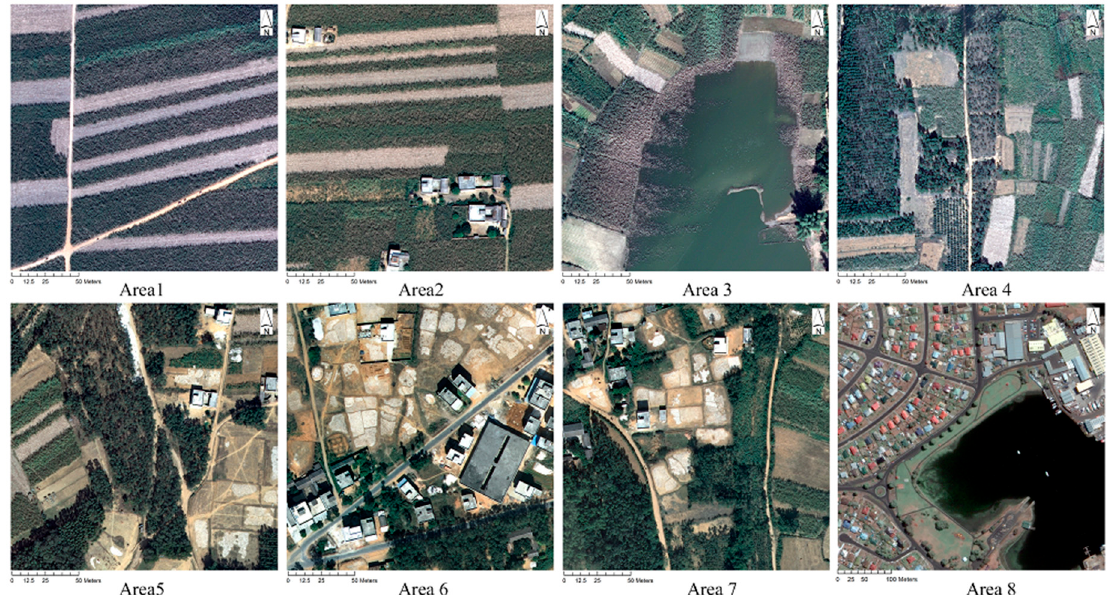
Figure 2. Study areas. Areas 1 to 7 are aerial images with 3 bands (R: 610-660 nm; G: 535–585 nm; and B: